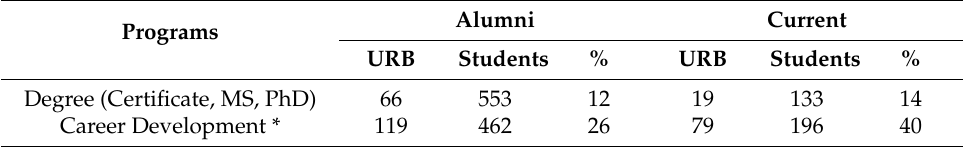
Table 1. ICRE Trainees from Underrepresented Backgrounds (URB),